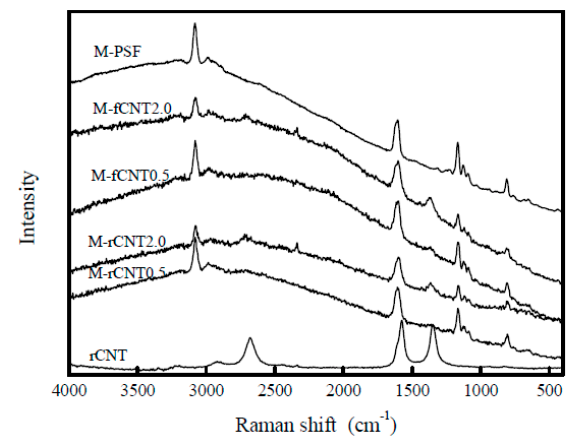
Figure 5. Raman spectra of the CNT composite membranes. (Reproduced with permission after [35]).